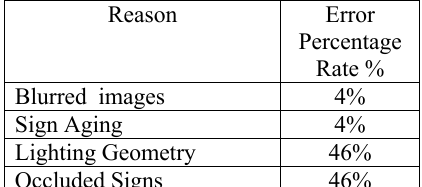
Figure 8. New speed region is always marked by two speed limit signs.